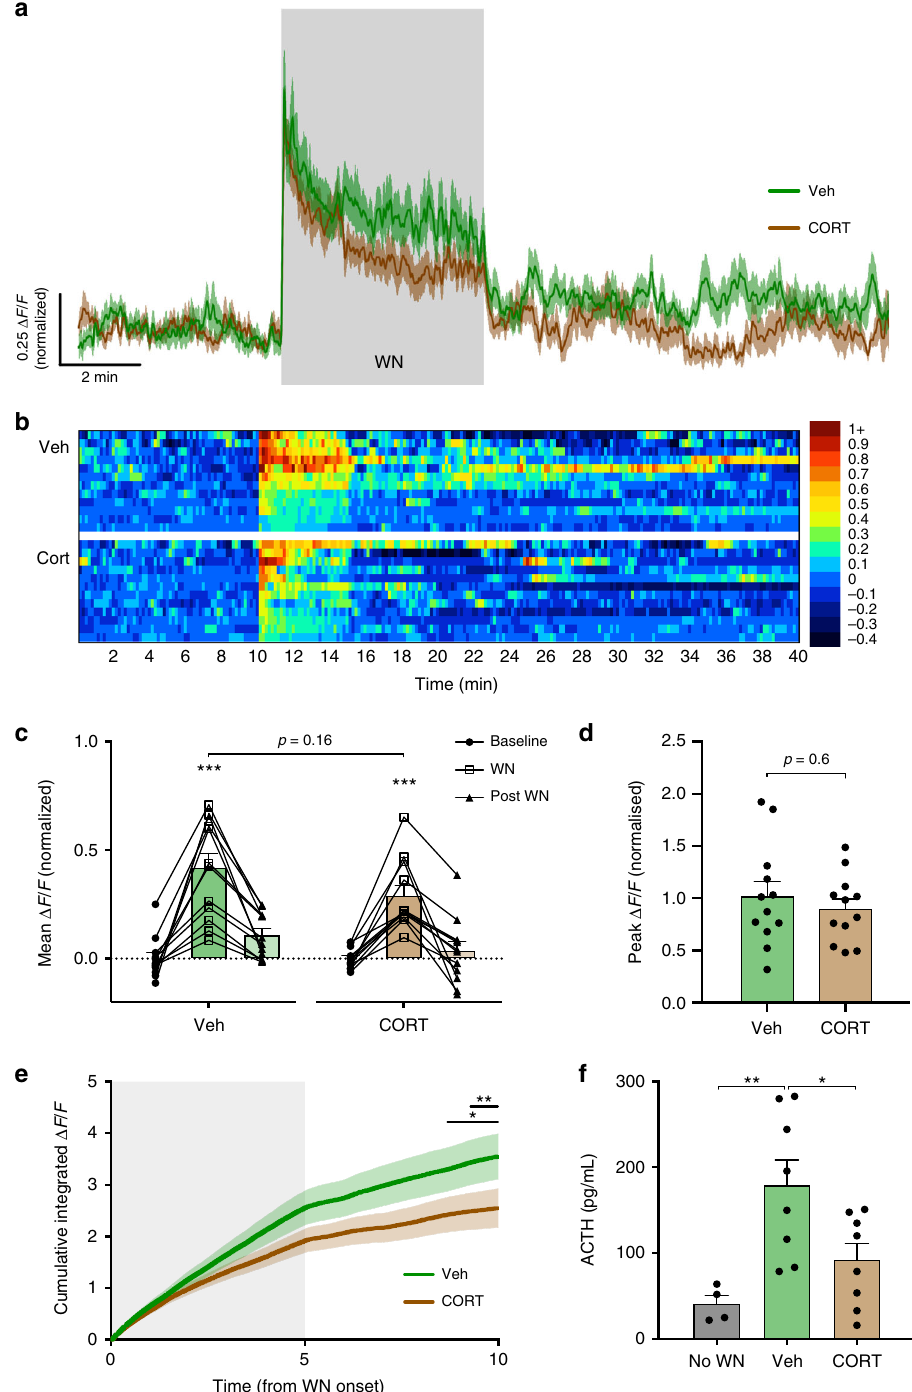
Fig. 5 Fast CORT feedback has little impact on CRH neural activity but faithfully suppresses ACTH release. a Mean photometry signals of CRH neuron activity during WN stress, 30 min after injection of either vehicle or CORT. b Heatmap of mean CRH neuron activity from all individual mice in 10 s bins. c Average Δ F / F across 5 min of CRH neuron activity before, during, and after WN; n = 12 per group, RM two-way ANOVA, *** p < 0.001 vs. baseline, Holm – Sidak; ANOVA interaction p = 0.19, ANOVA main effect of group p = 0.14. d Peak Δ F / F at WN onset; Mann – Whitney test. e Cumulative integrated Δ F / F from the time of WN stress; RM two-way ANOVA, * p < 0.05 Veh vs. CORT, Holm – Sidak; ANOVA interaction p < 0.001, ANOVA main effect of group p = 0.21. Lines indicate points at which statistical signi fi cance was reached and its duration. Gray shaded area indicates duration of WN. f Plasma ACTH levels 5 min post WN; one-way ANOVA, Tukey ’ s multiple comparison test. All data presented as mean ± SEM, * p < 0.05, ** p < 0.01, *** p <